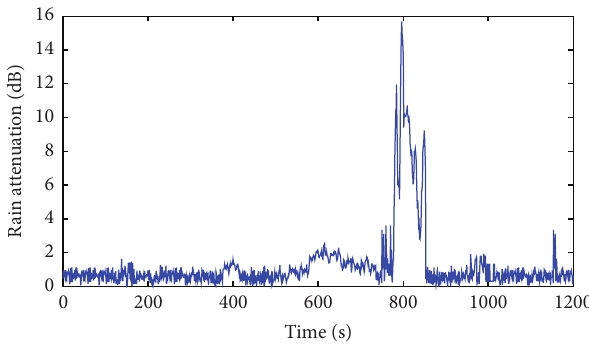
Figure 14: Measured rain attenuation stationary